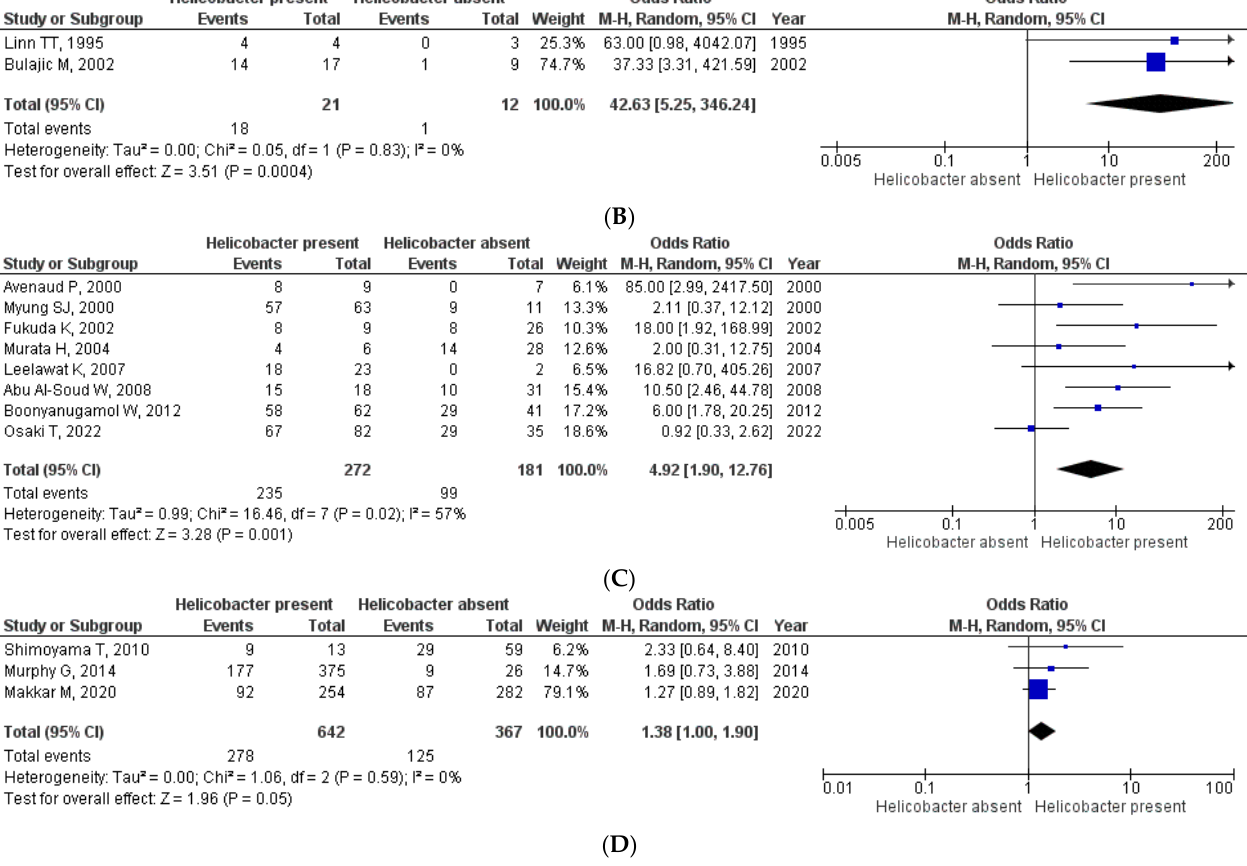
Figure 4. Forest plots of studies evaluating the risk of hepatobiliary tract malignancies according to the presence or absence of Helicobacter spp. infection assessed in different types of specimens: panel A: bile; panel B: gastric tissue; panel C: liver/biliary tissue; panel D: serum.